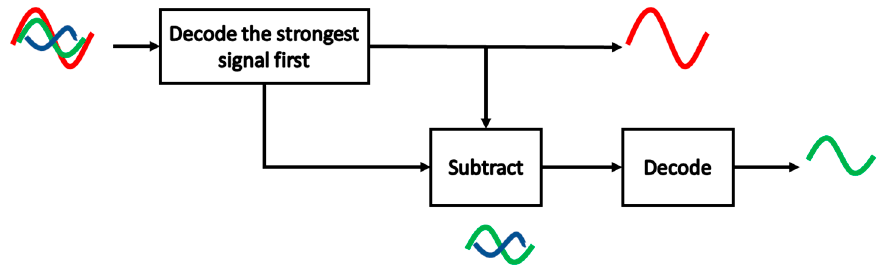
Figure 3. Successive interference cancellation (SIC) algorithm [6].